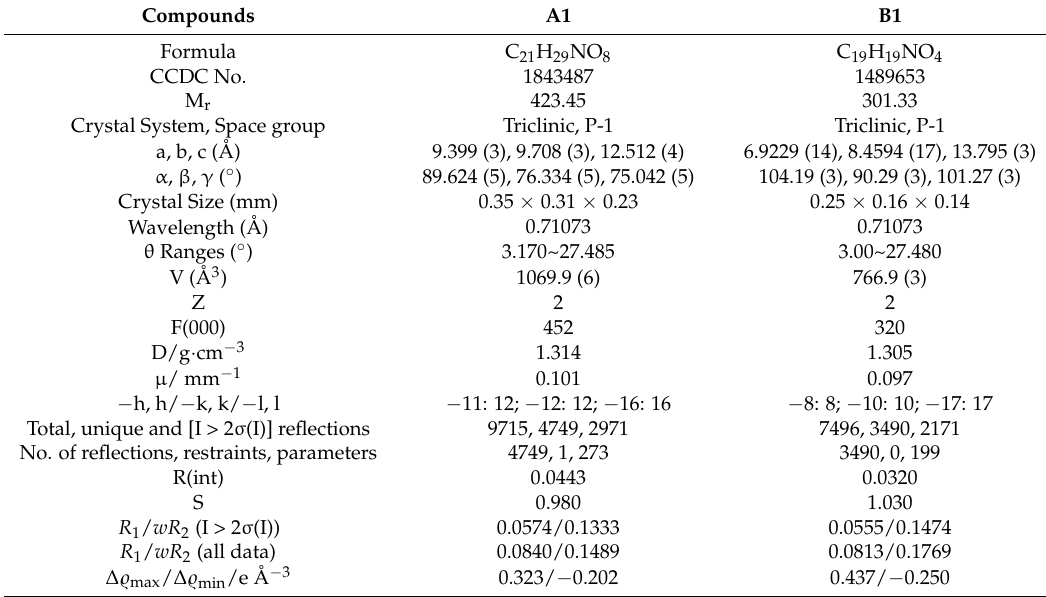
Table 1. Crystallographic data and depository number for A1 and B1